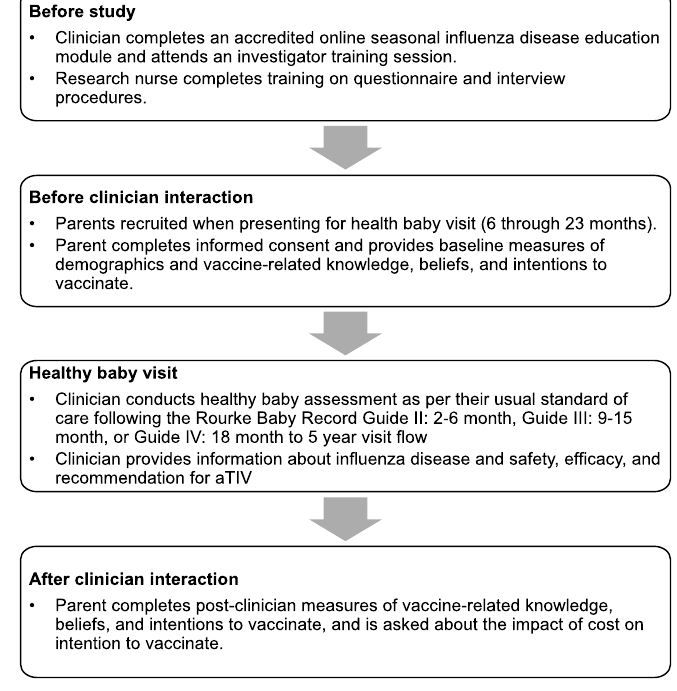
Figure 1. Study recruitment procedures and protocol flow.